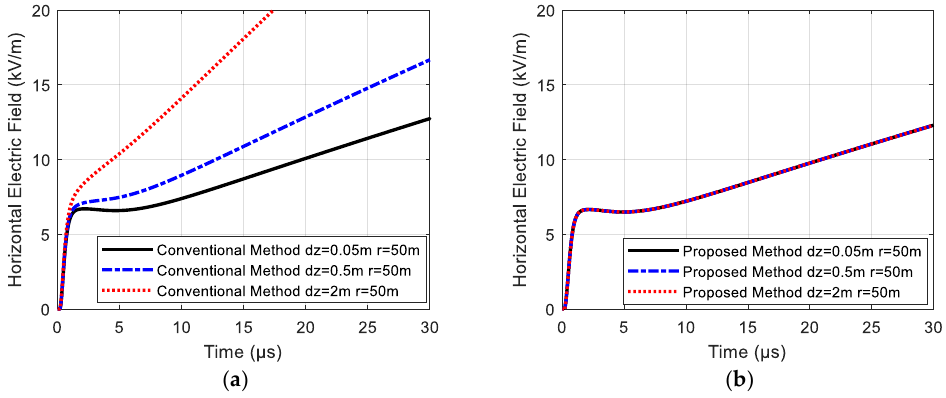
Figure 3. The time-domain evolutions of the horizontal electric field at the observation point under di ff erent dz (cid:48) ; ( a ) calculated by the conventional method; ( b ) calculated by the proposed